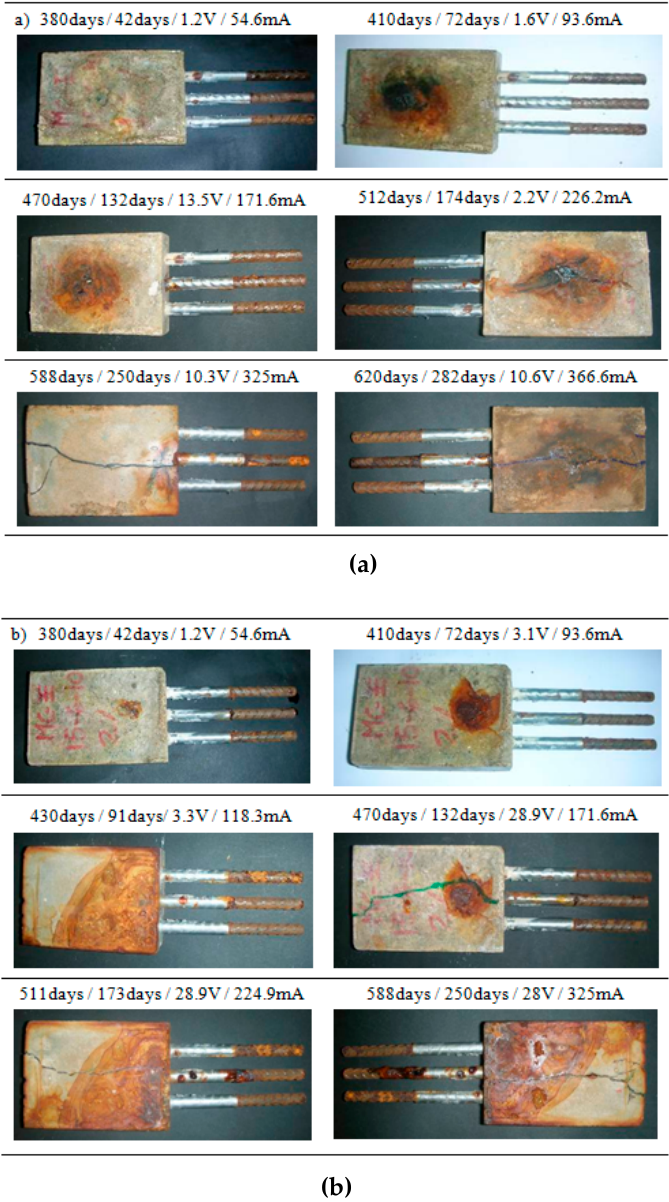
Figure 7. Symptoms in the MCE test specimen with 1.2% chloride ions ( a ) and 2% chloride ions ( b ).